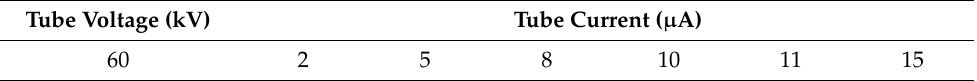
Table 2. Test tube voltage and current of spectral acquisition conditions.